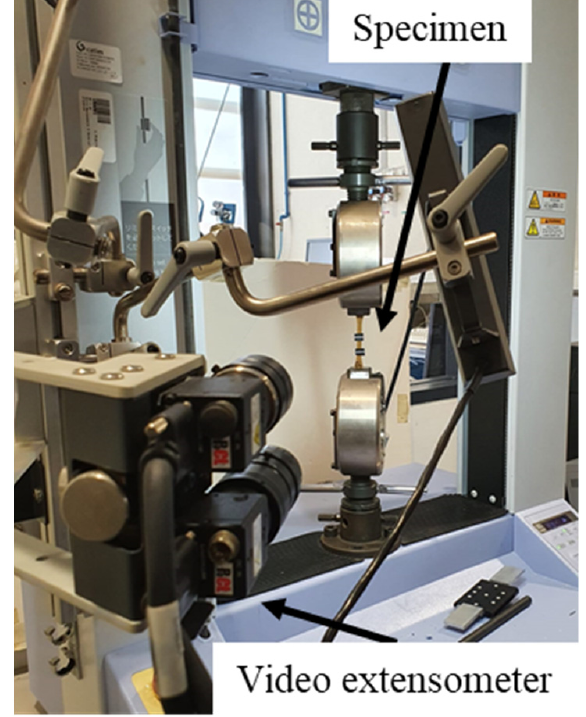
Figure 5. Tensile test setup.